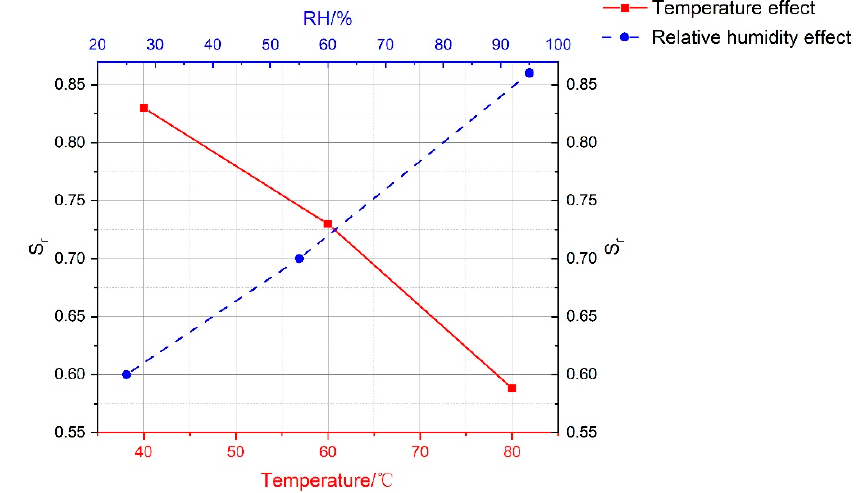
Figure 10. Relationship curves of average relative peak stress of testing specimens. Materials 2020 , 13 , x FOR PEER REVIEW